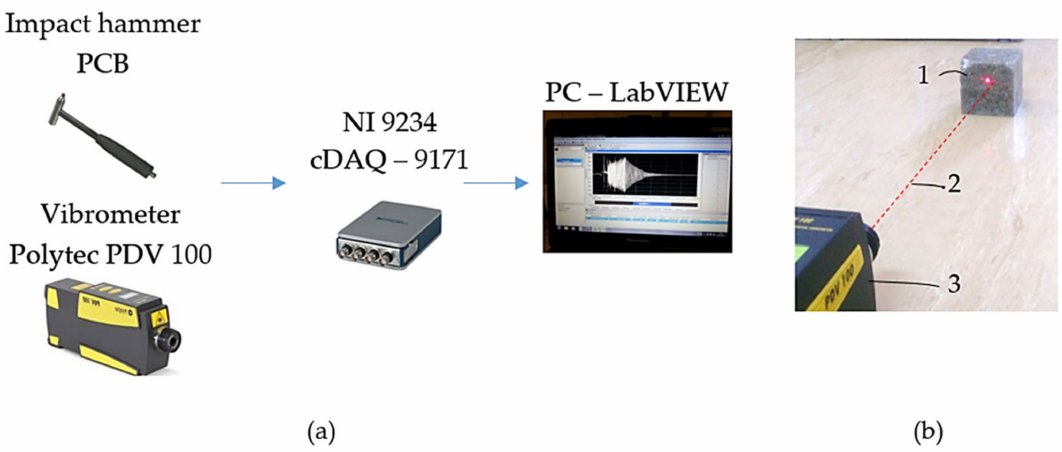
Figure 3. ( a ) Measurement chain, ( b ) details of measurement (1: sample; 2: laser beam; 3: